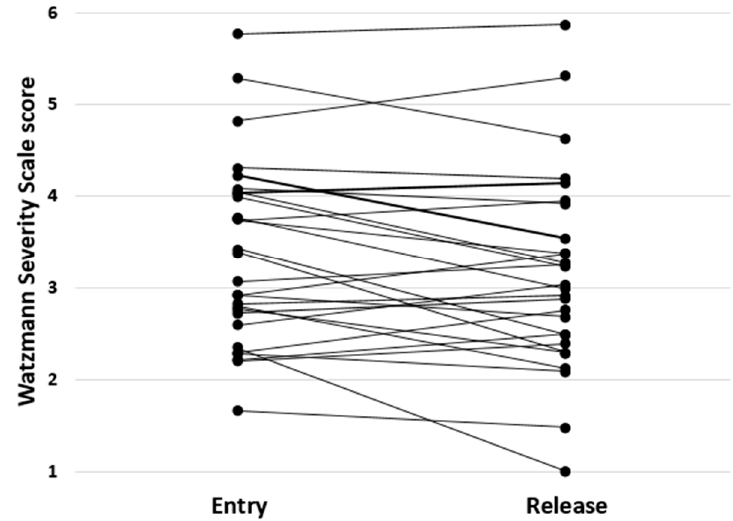
Figure 1. WSS scores at the entry and the release of all 28 patients. Each line represents the change of the WSS of a single patient over the course of inpatient rehabilitation. Table 1. Patient characteristics, sensorimotor performance, and actigraphy of 28 MS patients.